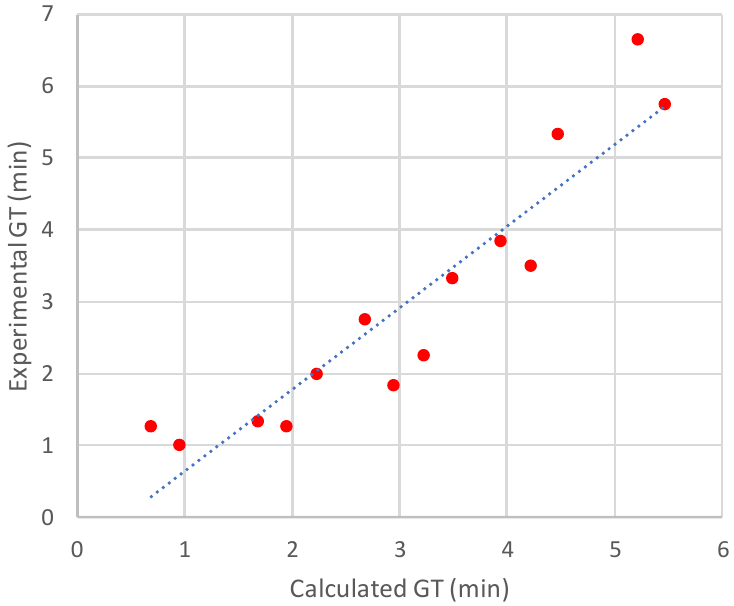
Figure 2. Correlation between the experimental gel time (GT) and the calculated GT using the equation: GT = 8.7 − 2.5 [T4epa] − 2 [Iod]. To better understand the localization of the Redox FRP process in time and in space, thermal imaging experiments in a narrow chemical pill box were realized under air (Fig- ure 3). Remarkably, it is found that the polymerization starts at the top air interface (t = 170s) before a frontal polymerization occurs from the top to the bottom (see for t = 180s and t = 190s). This suggests that the oxygen positively participates to the redox initiation in agree- ment with the ability of the proposed T4epa/Iod RIS to overcome the oxygen inhibition vs. the classical BPO/amine systems that are usually highly inhibited.